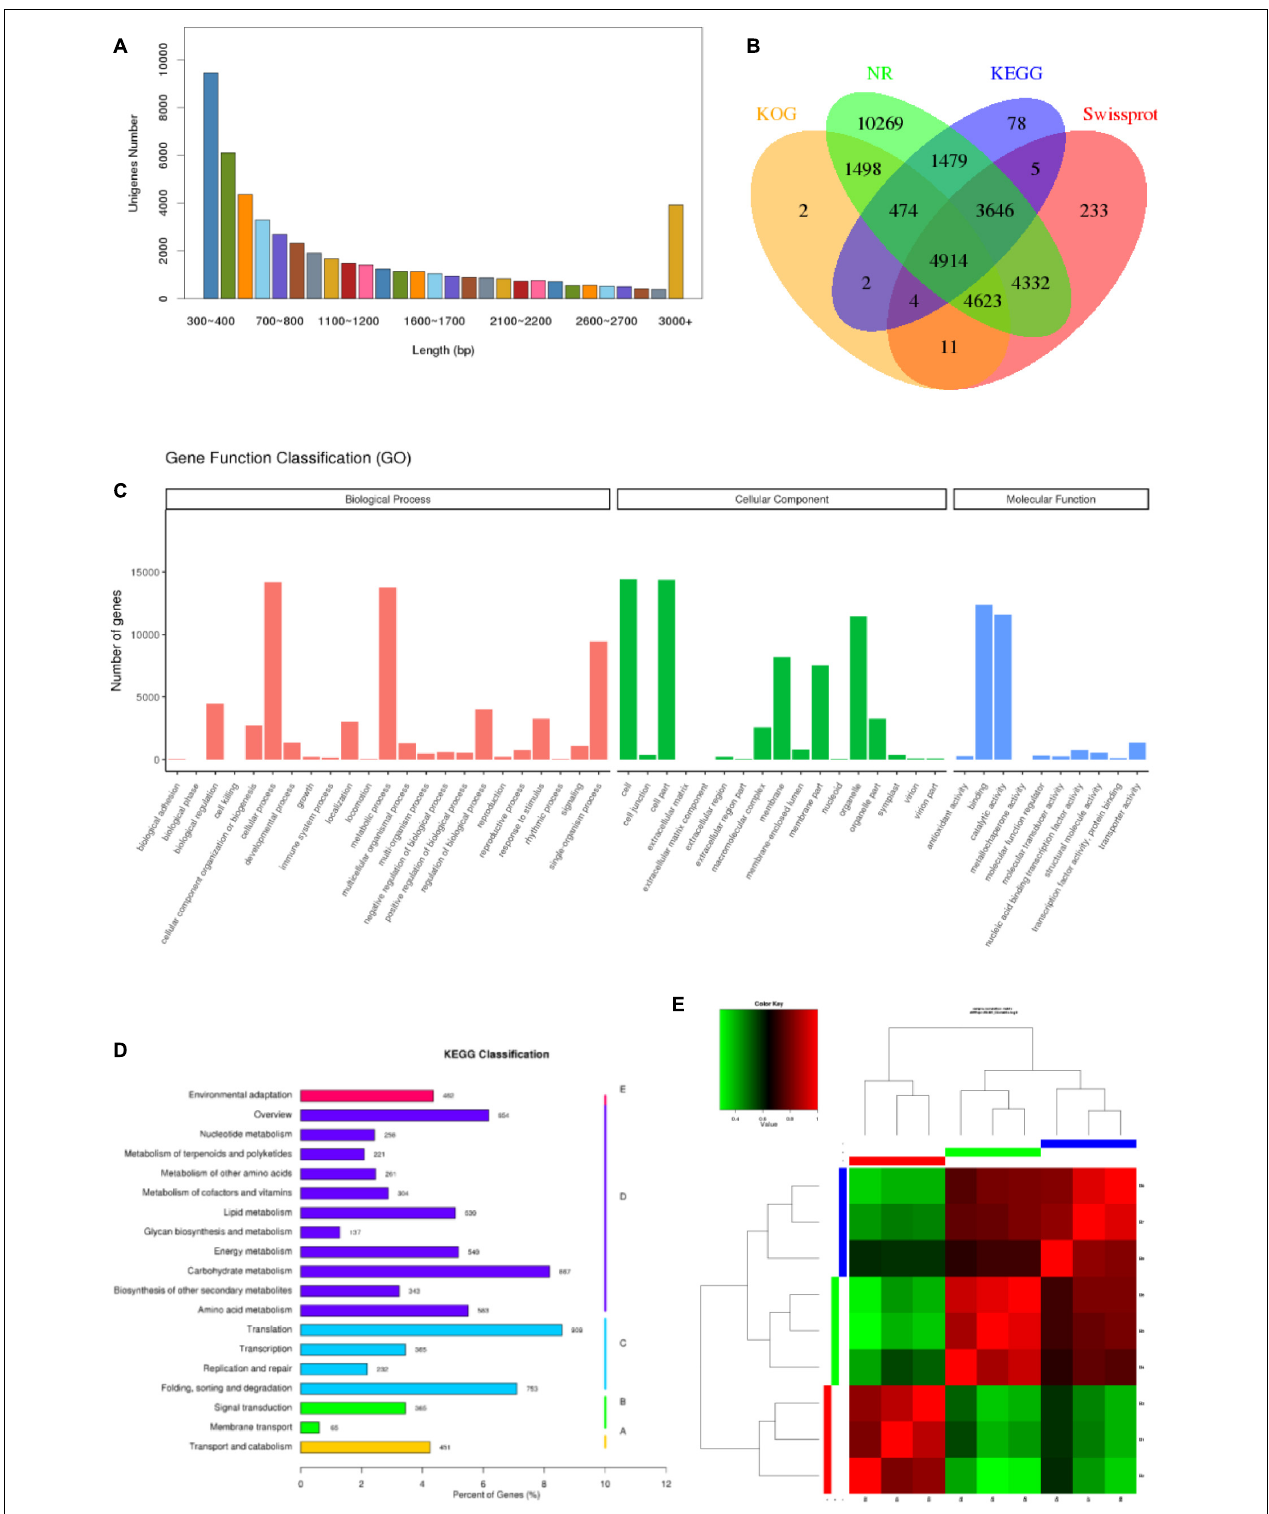
FIGURE 2 | Characteristics of unigenes and samples. (A) Pattern of length distribution in unigenes of P. antidotale. (B) The proportion of transcripts annotated to different databases at the same time. (C) Distribution of identified genes as per Gene Ontology (GO) classification. (D) Distribution of identified genes as per Kyoto Encyclopedia of Genes and Genomes (KEGG) classification. (E) Correlation analysis between the